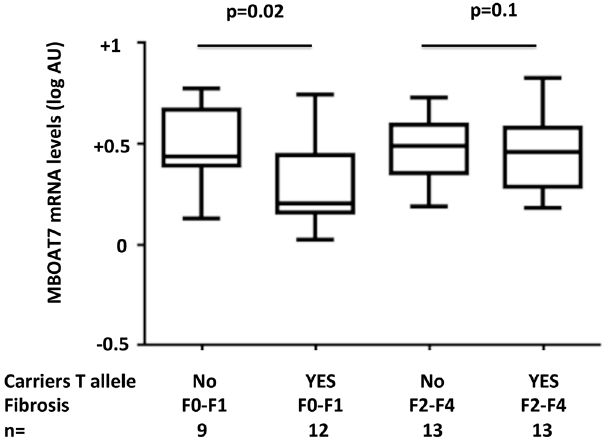
Figure 3. Impact of the presence of rs643718 risk T allele on MBOAT7 expression (log mRNA levels) in 47 patients with NAFLD from the Milan Hepatology service stratified by the presence of clinically significant hepatic fibrosis (stage F2-F4). Data were compared by Student’s